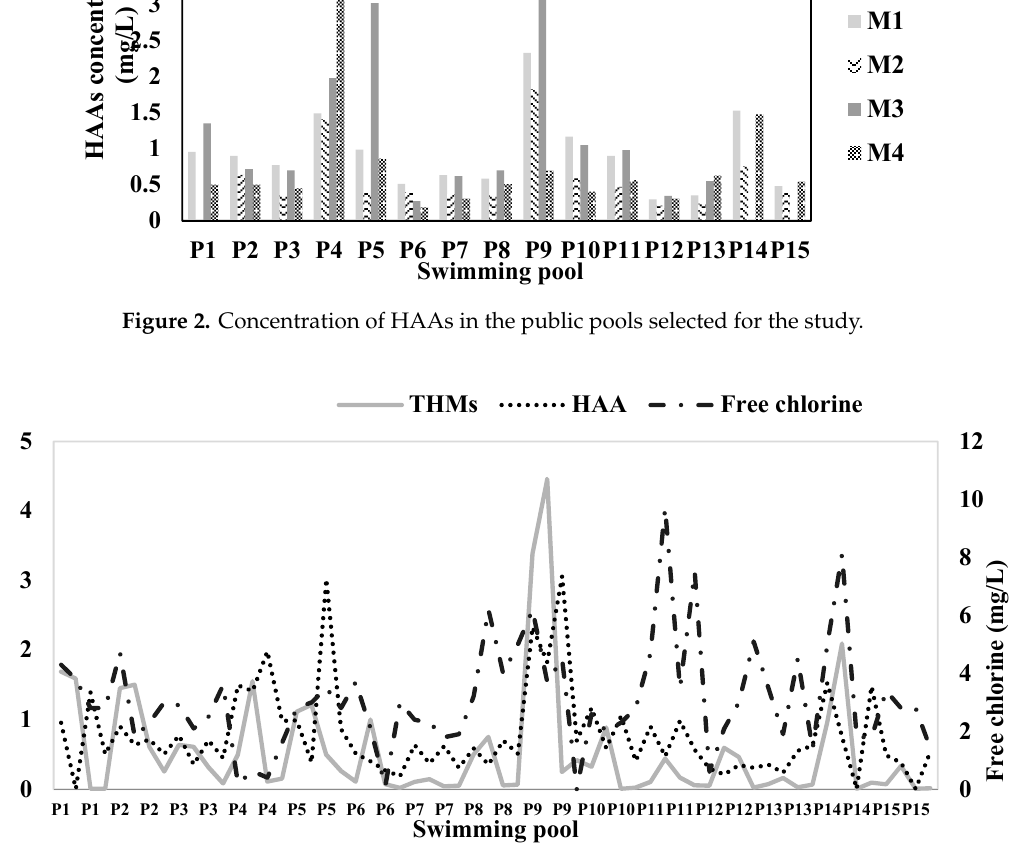
Figure 2. Concentration of HAAs in the public pools selected for the study.